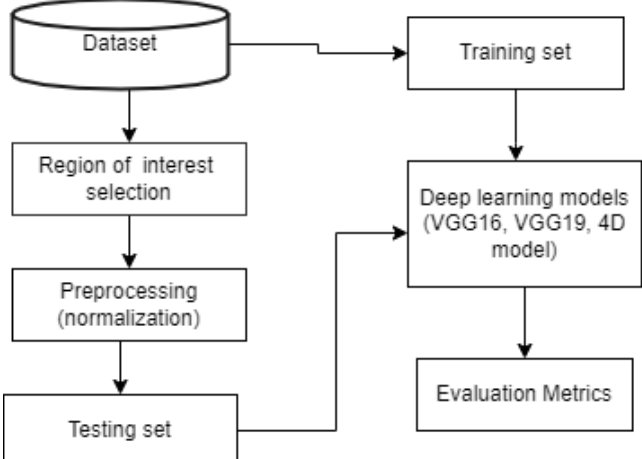
Figure 2. Diagram of the proposed model.